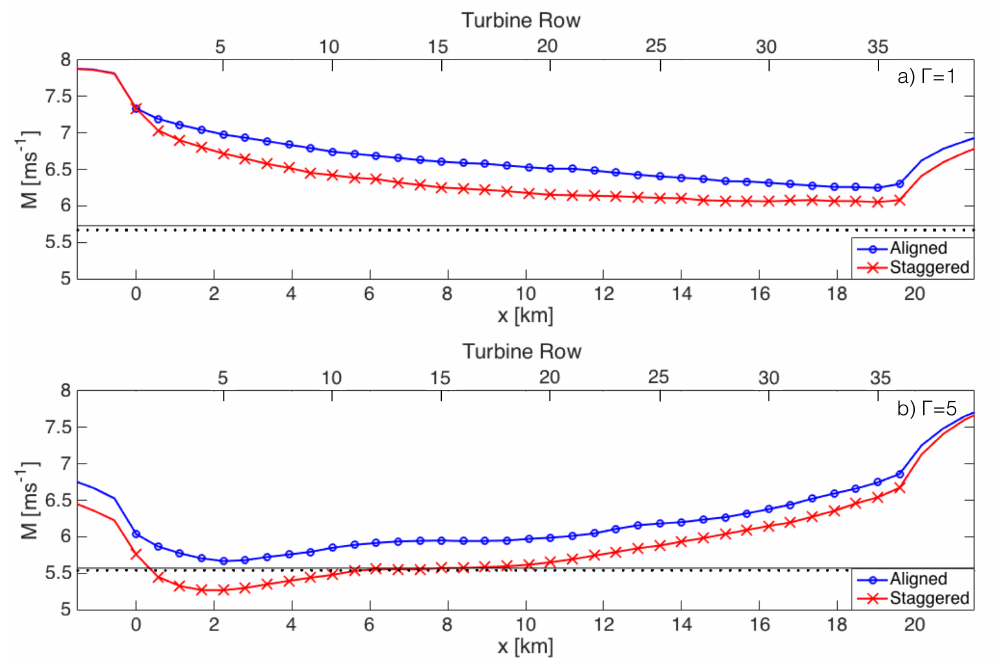
Figure 8. Time- and horizontally-averaged (the distance of streamwise averaging is 7D, with the turbine row placed at the center) velocity magnitude at the hub height at different wind turbine rows for the wind farm cases under ( a ) Γ = 1 K/km; and ( b ) Γ = 5 K/km. The black horizontal dotted and solid lines are the time- and horizontally-averaged velocity magnitude at the hub height for the corresponding aligned and staggered infinite wind farm cases,